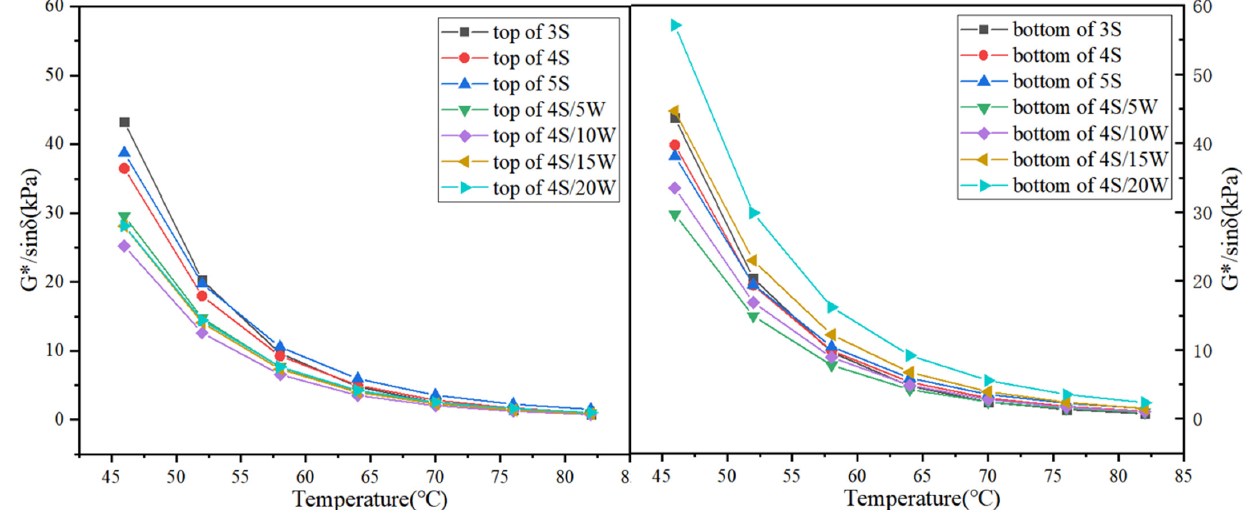
Figure 11. Segregation of G * /sin δ at top and bottom samples of WPU/SBS composite modified asphalt.